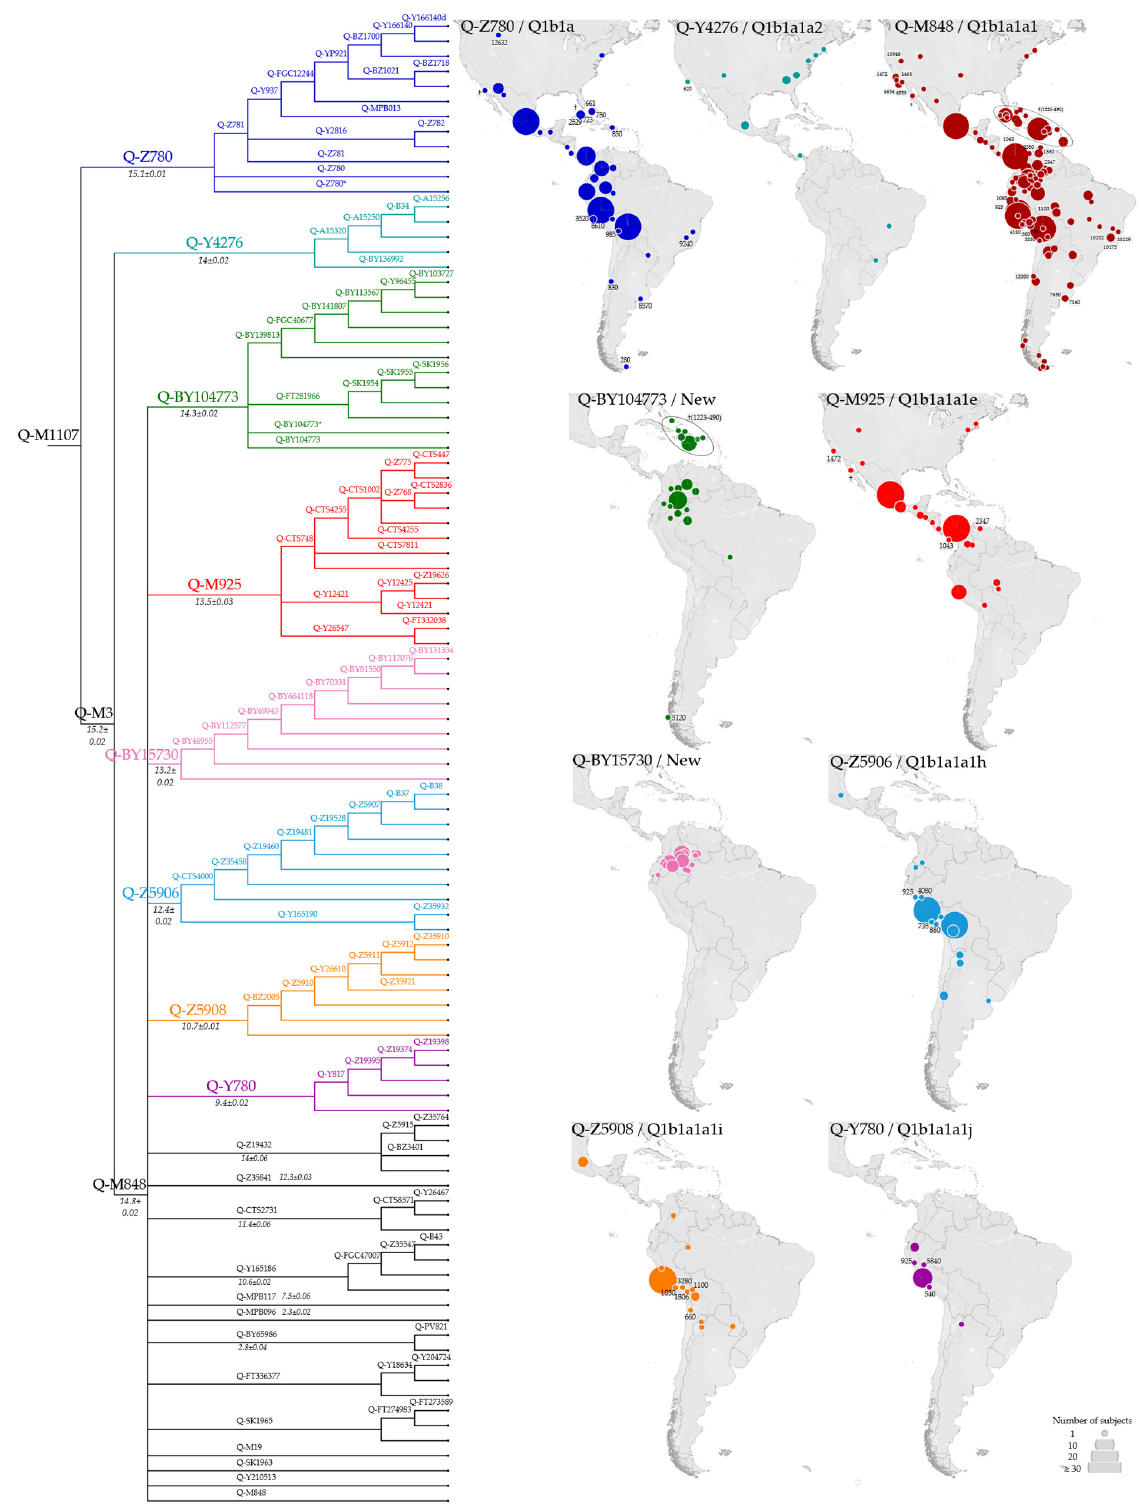
Figure 3. Phylogenetic structure of the American-specific haplogroup Q-M1107. The maps on the right show the geographic distribution of the major Q-M1107 sub-lineages. Ancient individuals are indicated with their median calibrated age (cal BP, see Table S1 for details), or with a cross when age was not available. ISOGG nomenclature (http://www.isogg.org/tree/, accessed on 19 January 2022) is reported, when available; “New” indicate branches not reported. In the phylogeny, the estimated ages of the main node (±StDev) are reported in kya.